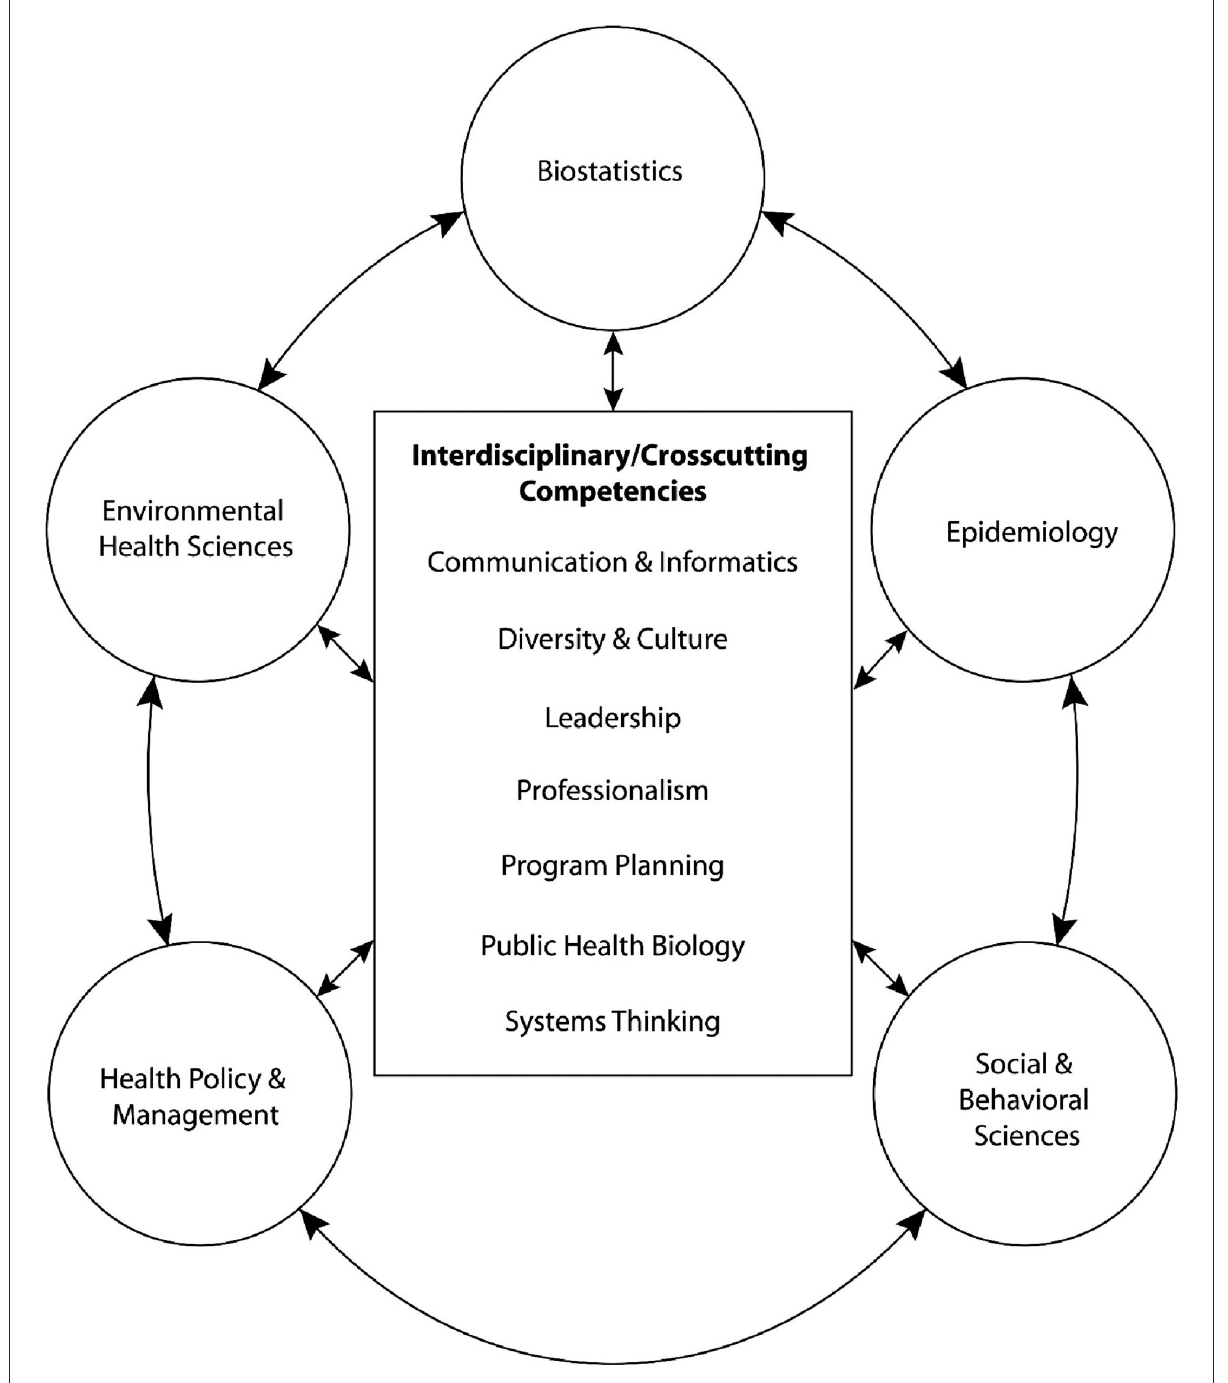
FIGURE1 Core competency model for the MPH degrees proposed by Association of Schools and Program of Public Health (ASPPH) 30.